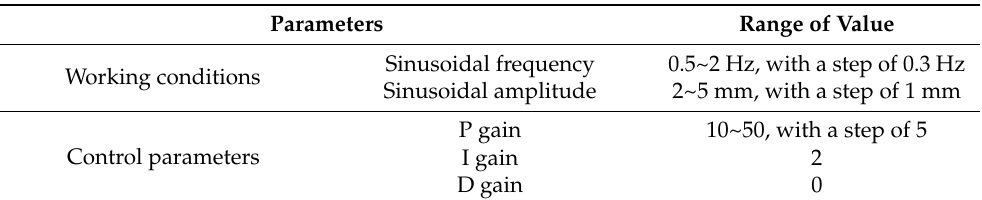
Figure 13. Schematic diagram of the experimental signal input and data acquisition. Table 5. Collection range of the learning samples.